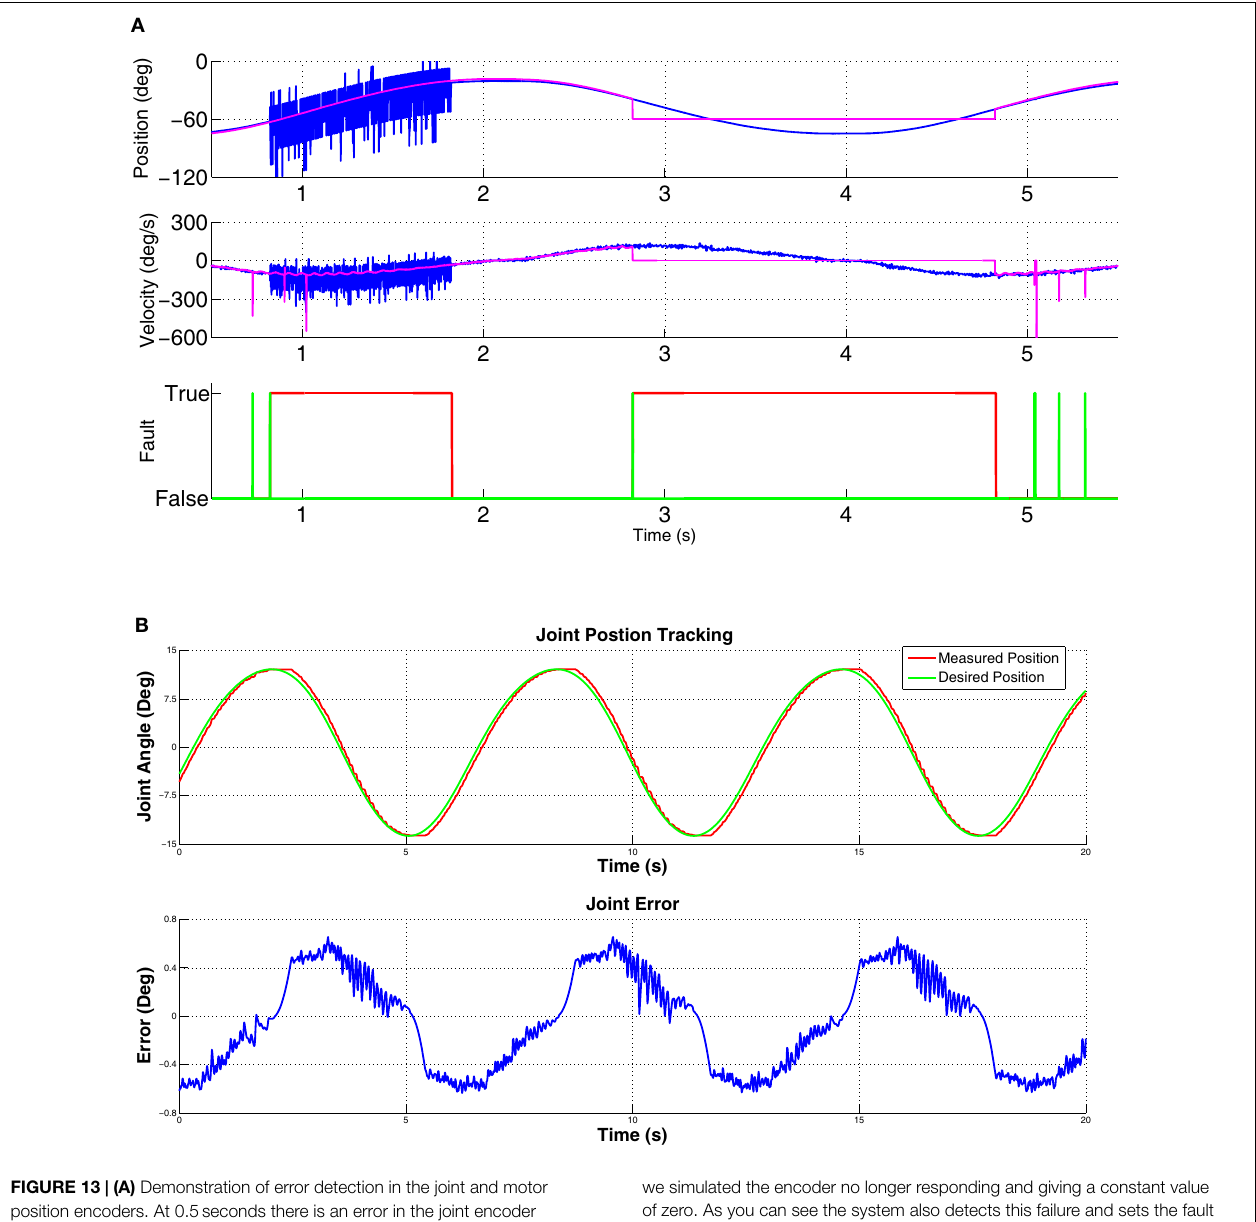
FIGURE 13 | (A) Demonstration of error detection in the joint and motor position encoders. At 0.5seconds there is an error in the joint encoder position, this could be from noise on the communication line or from the encoder. This is detected and shown with the first green fault detection. Then after 0.7seconds we simulated an error on the motor encoder for 1second which simulates a faulty sensor. This fault is detected and classed as a sensor failure as seen with the red fault detection being red. At 2.8seconds